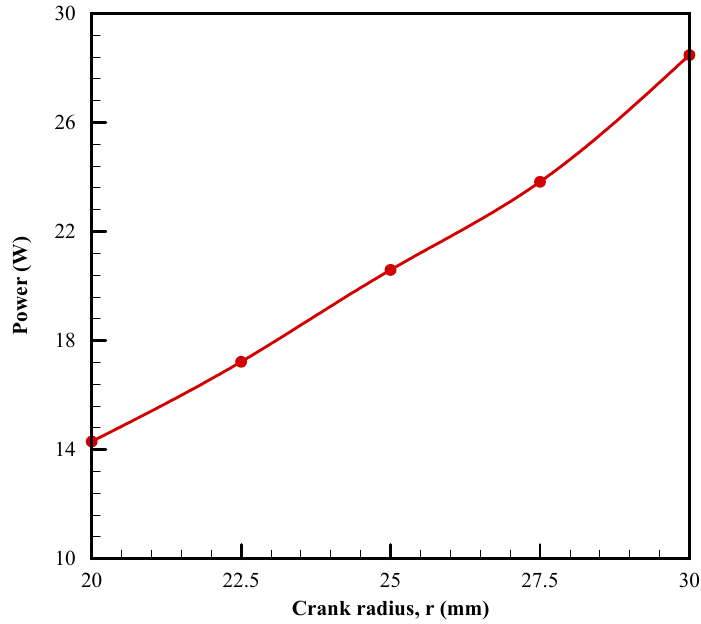
Figure 8. Variation of the engine power with the crank radius.